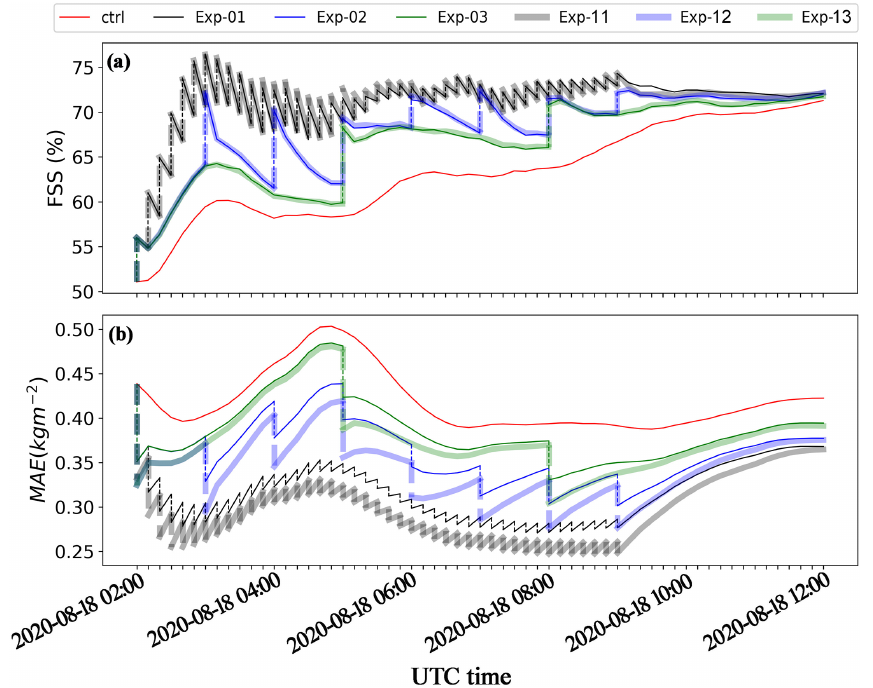
Figure 13. Time evolution of (a) FSS and (b) MAE of the ensemble mean of the first-guess forecast and analysis of CWP for cycled DA experiments with different outlier threshold values.